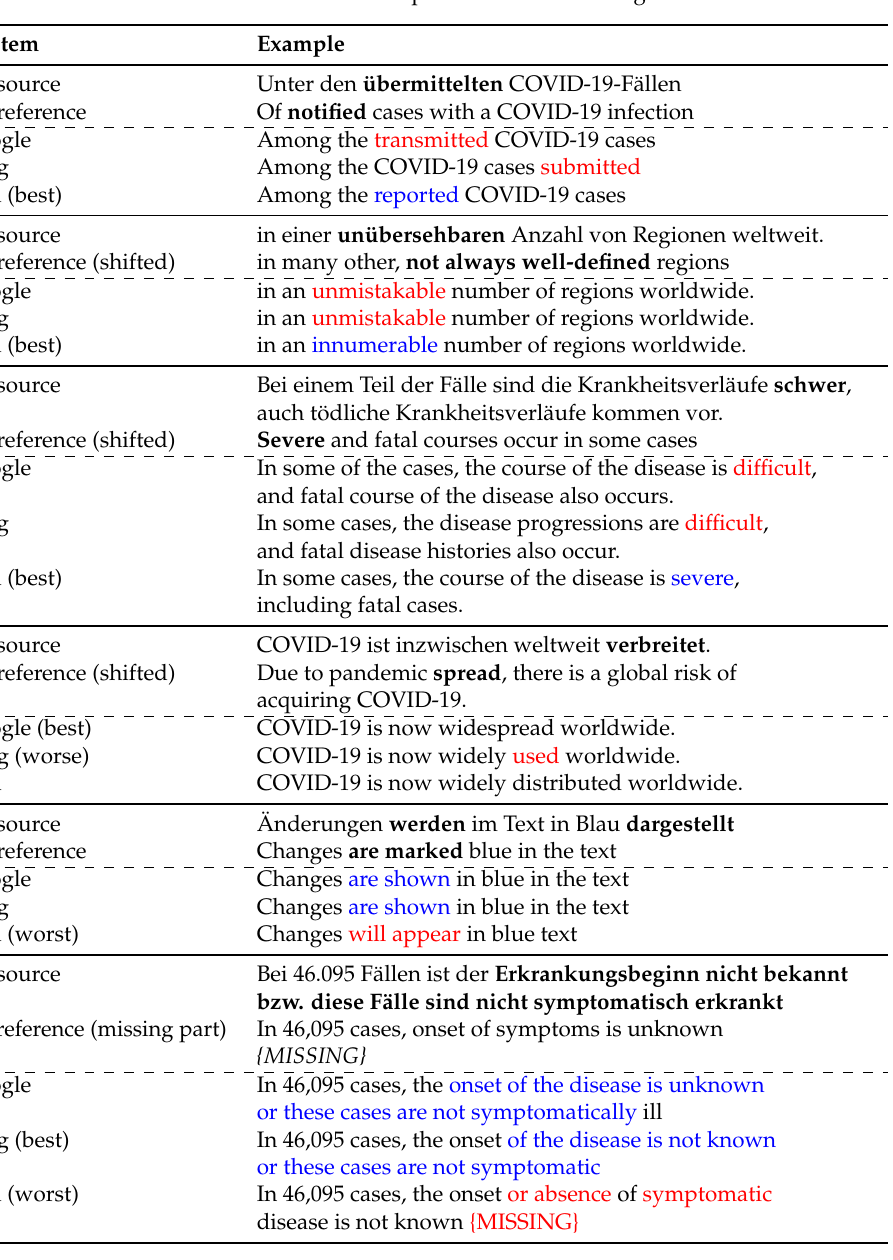
Table 9. Translation examples for